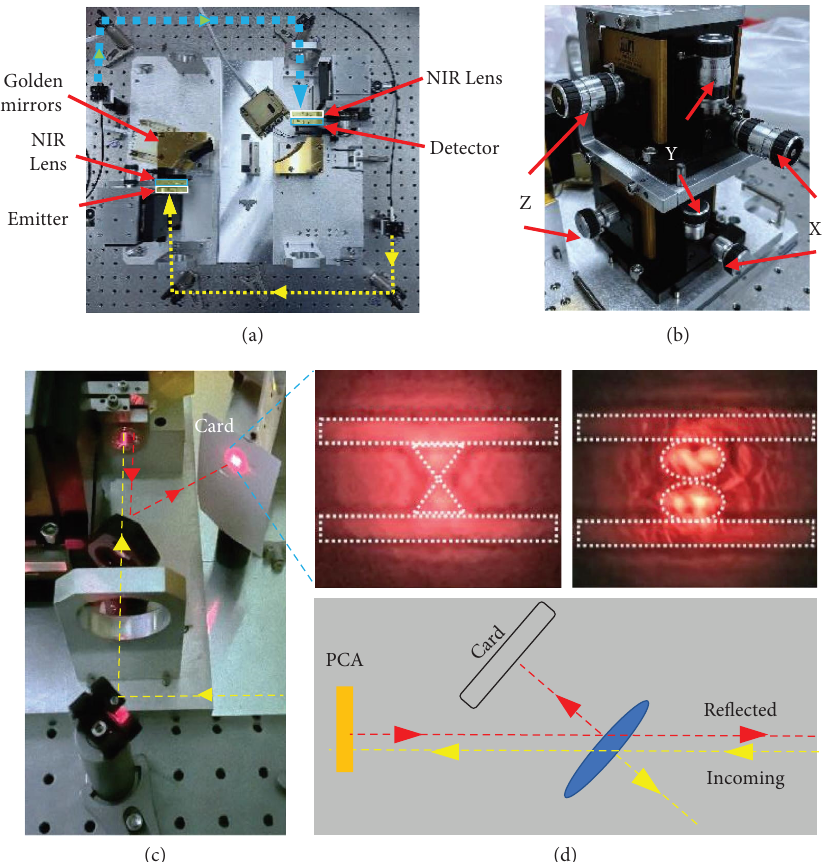
Figure 6: Photos of the time-domain spectroscopy (TDS) system (TeraAlign): (a) THz part, (b) 3D alignment stages for NIR (top) and THz (bottom), (c) refection setup with bowtie (top) and circular (bottom) electrodes, and (d) diagram showing the function of a beam splitter used in